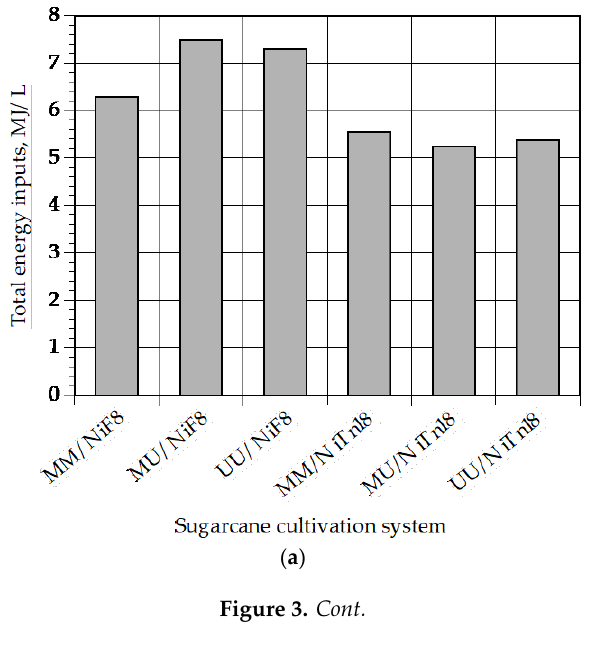
Figure 2. Ethanol yields estimated for the combined cultivation systems of three polyethylene mulch treatments and two cultivars. MM, mulching at planting and every ratooning; MU, mulching only at planting; UU, untreated, i.e., no mulching at all. NiF8, a conventional cultivar; NiTn18, a cultivar characterized by improved yielding capacity and cold tolerance.